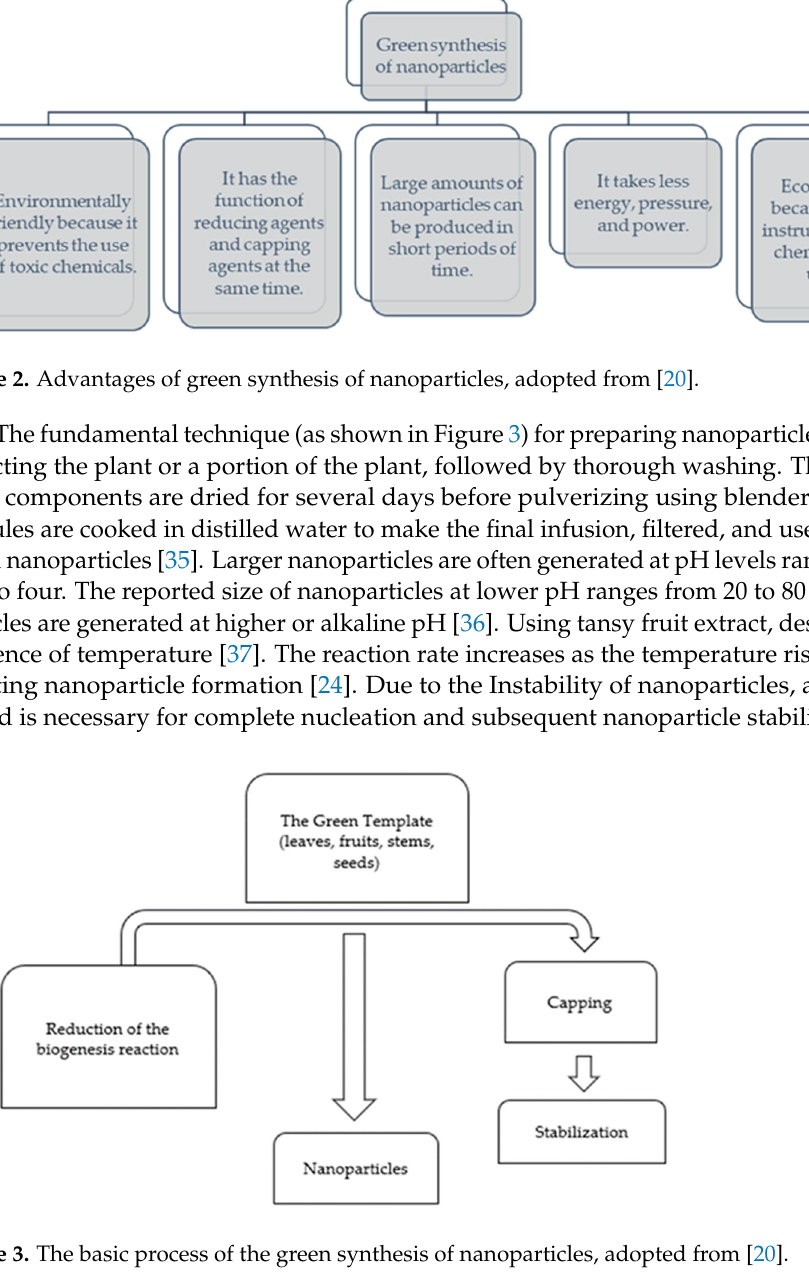
Figure 4. Classification synthesis method of HA, adopted from [40] The agglomeration problem affects all of the processes outlined above. Aggregation or agglomeration occurs during the synthesis of various nanomaterials and the produc- tion of HA. Because of the interfacial area’s limits, agglomeration decreases nanoparticles’ mechanical characteristics [40–43]. The agglomeration problem is overcome by introduc- ing capping agents or surfactants to ensure excellent particle dispersion by preventing the attraction interactions between the nanoparticles [44,45]. Another reason to prefer HA produced using easily accessible natural precursors is the material’s high cost.